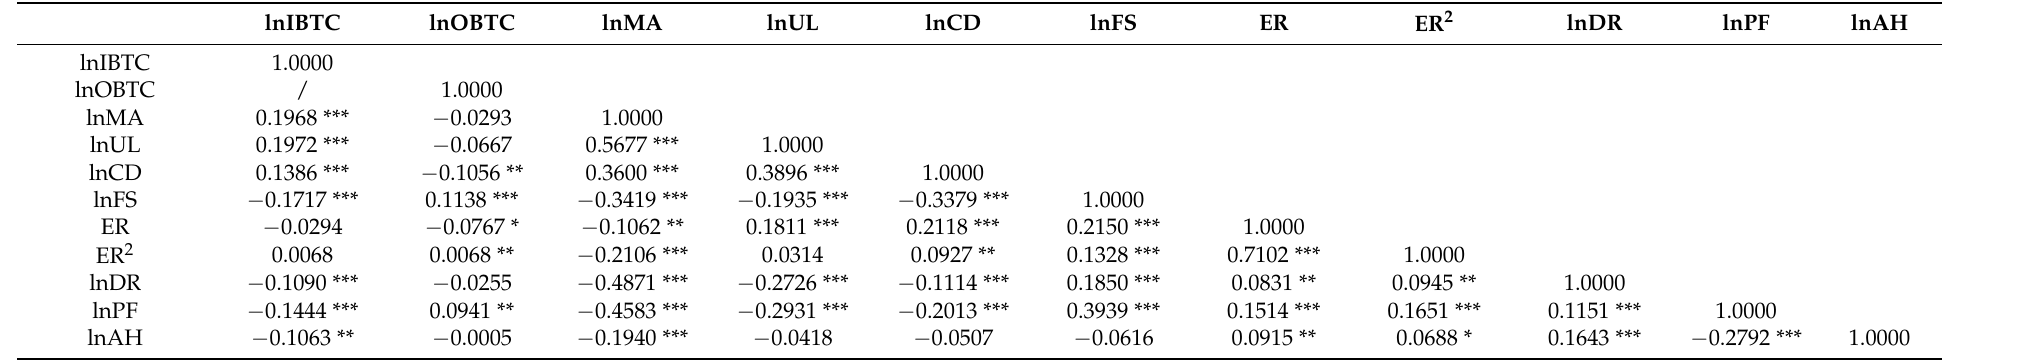
Table 7. Correlation